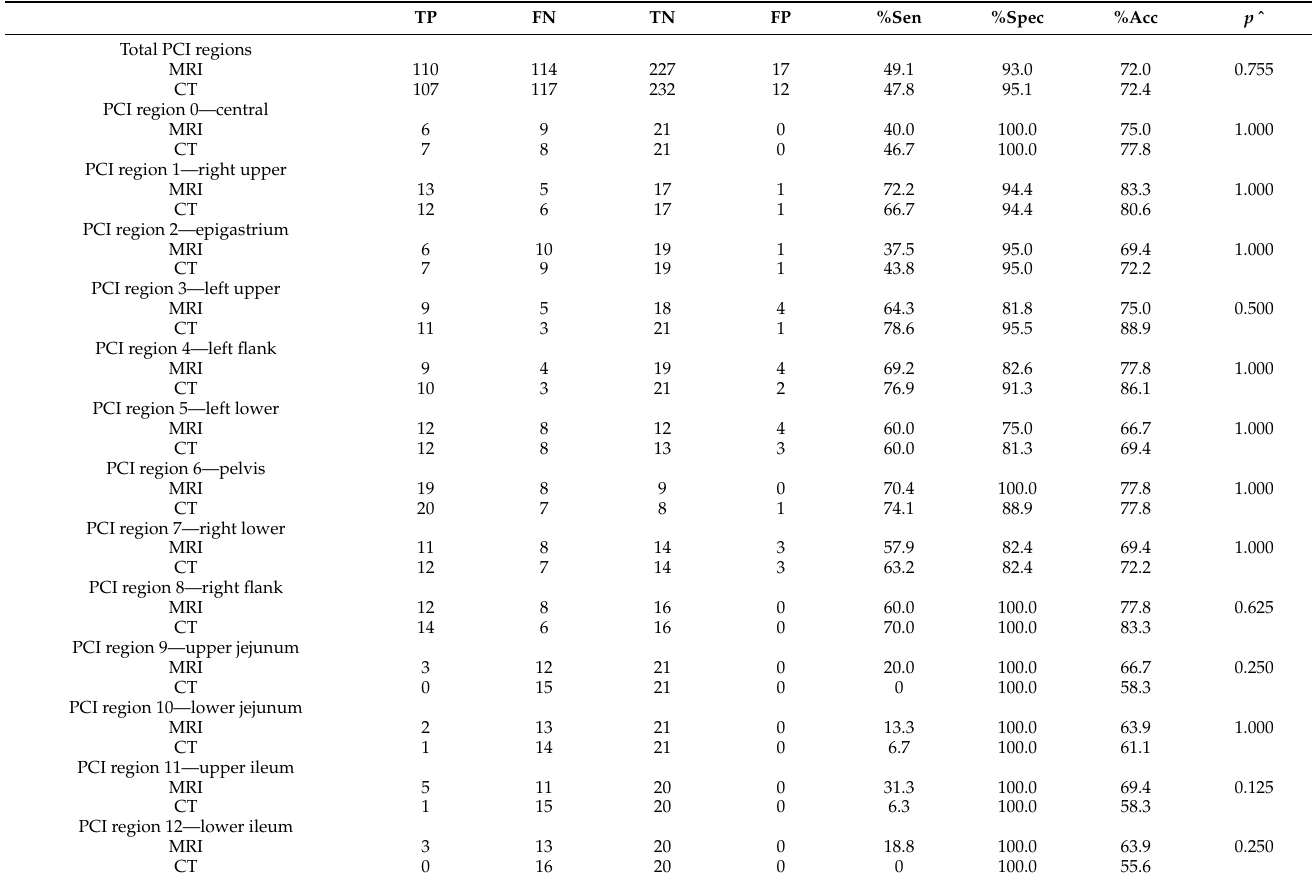
Table 1. Comparison of tumor detection on imaging against intra-operative findings.